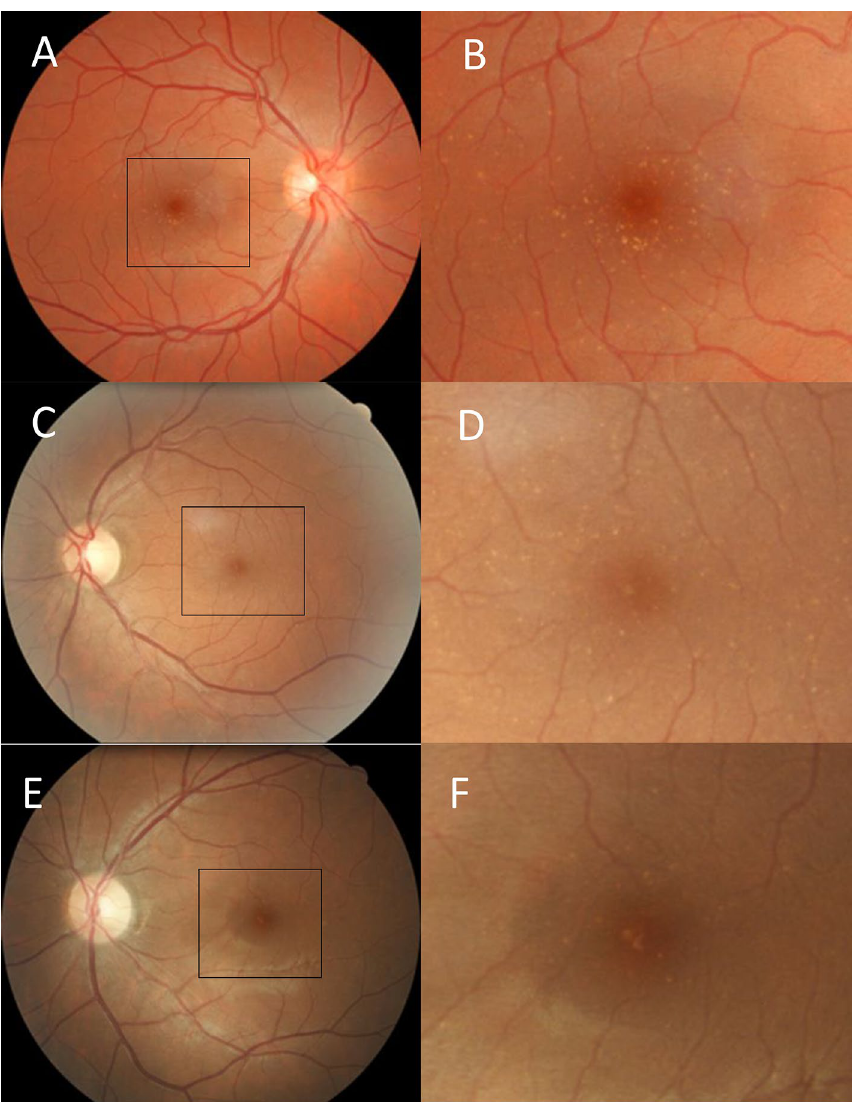
Figure 1. Retinal views of the central retina in three individuals with IgA glomerulonephritis ( A , C , E ) with enlarged views of the central retina demonstrating drusen ( B , D , F